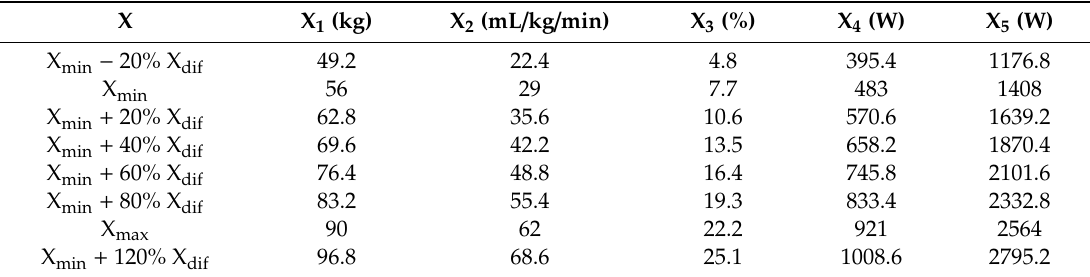
Table 2. The predictors of each predictive